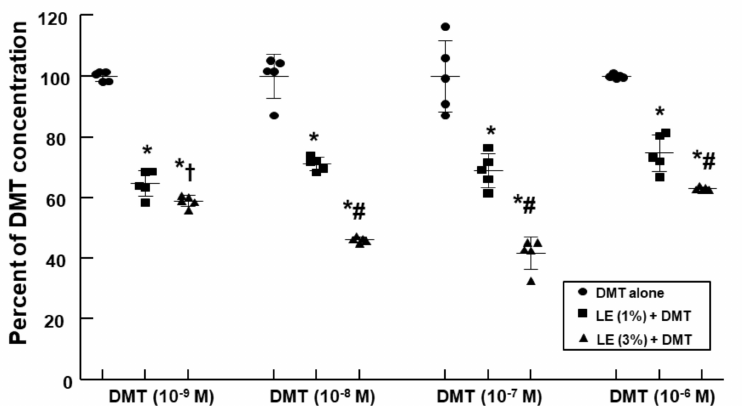
Figure 4. Effect of lipid emulsion (LE) on the dexmedetomidine (DMT) concentration in the Krebs so- lution. DMT concentration was analyzed using ultraperformance liquid chromatography-quadrupole time-of-flight mass spectrometry with multiple reaction monitoring mode. Data ( n = 5) are shown as mean ± standard deviation and expressed as the percentage of each DMT (10 − 9 , 10 − 8 , 10 − 7 , and 10 − 6 M) concentration alone. * p < 0.001 versus DMT alone. † p < 0.05 and # p < 0.001 versus LE (1%) +